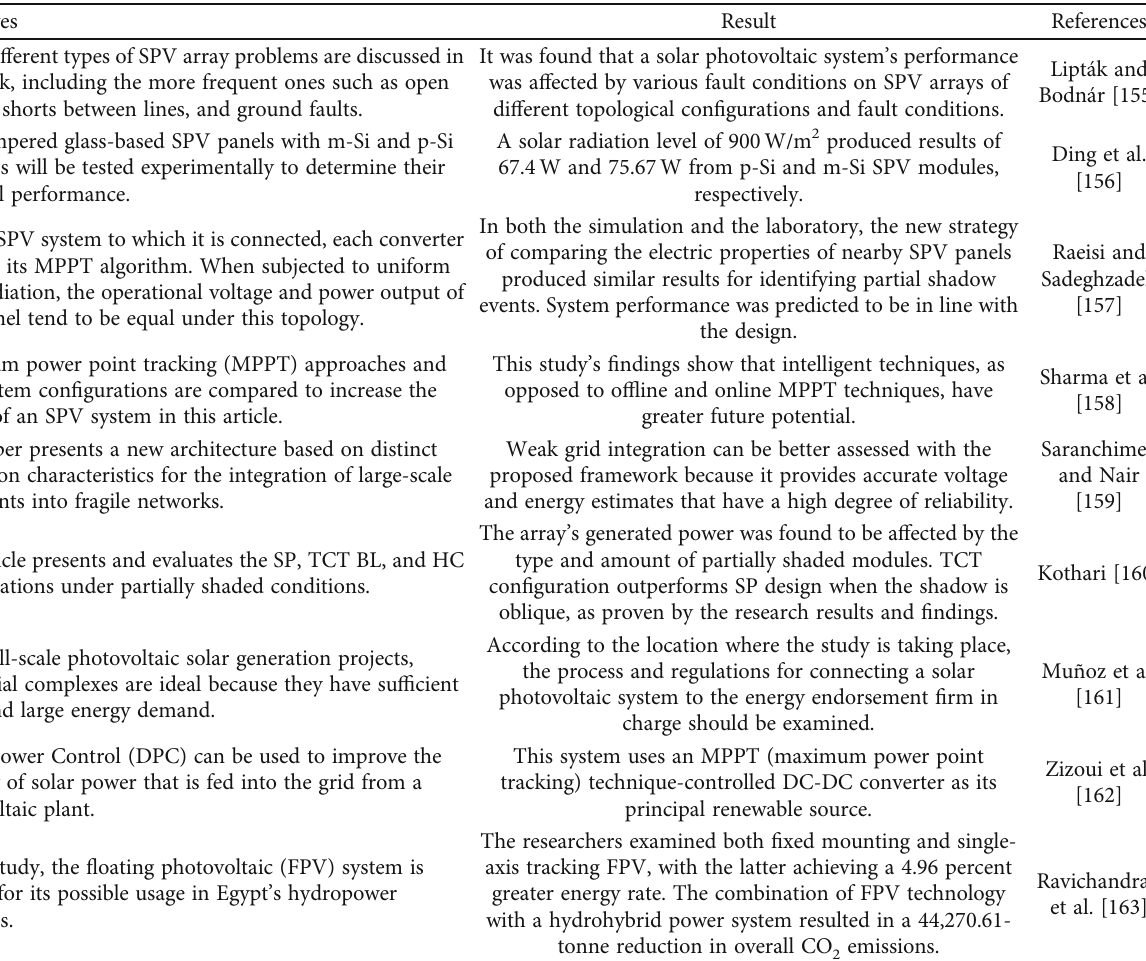
Table 6: Studies on the e ff ect of di ff erent topological